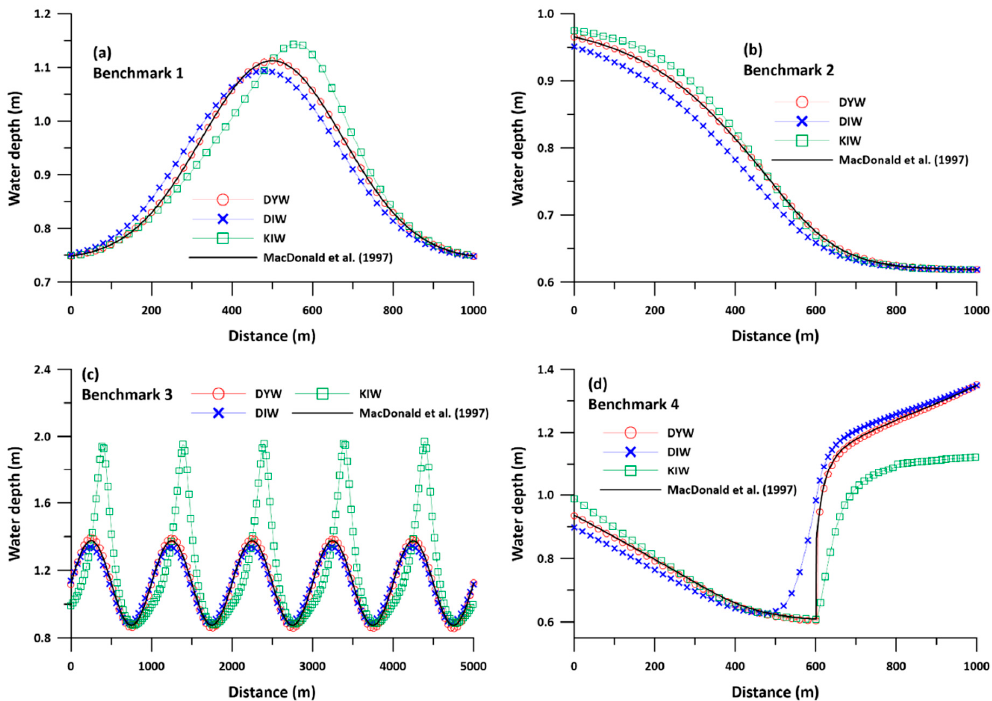
Figure 6. Comparison between the DYW, DIW, and KIW flows simulated by CAMP1DF of ( a ) benchmark 1, ( b ) benchmark 2, ( c ) benchmark 3, and ( d ) benchmark 4 of MacDonald et al. (1997) Table 4. Error calculations obtained from the CAMP1DF DYW/DIW/KIW simulations and analytical results by MacDonald et al. (1997) [30].